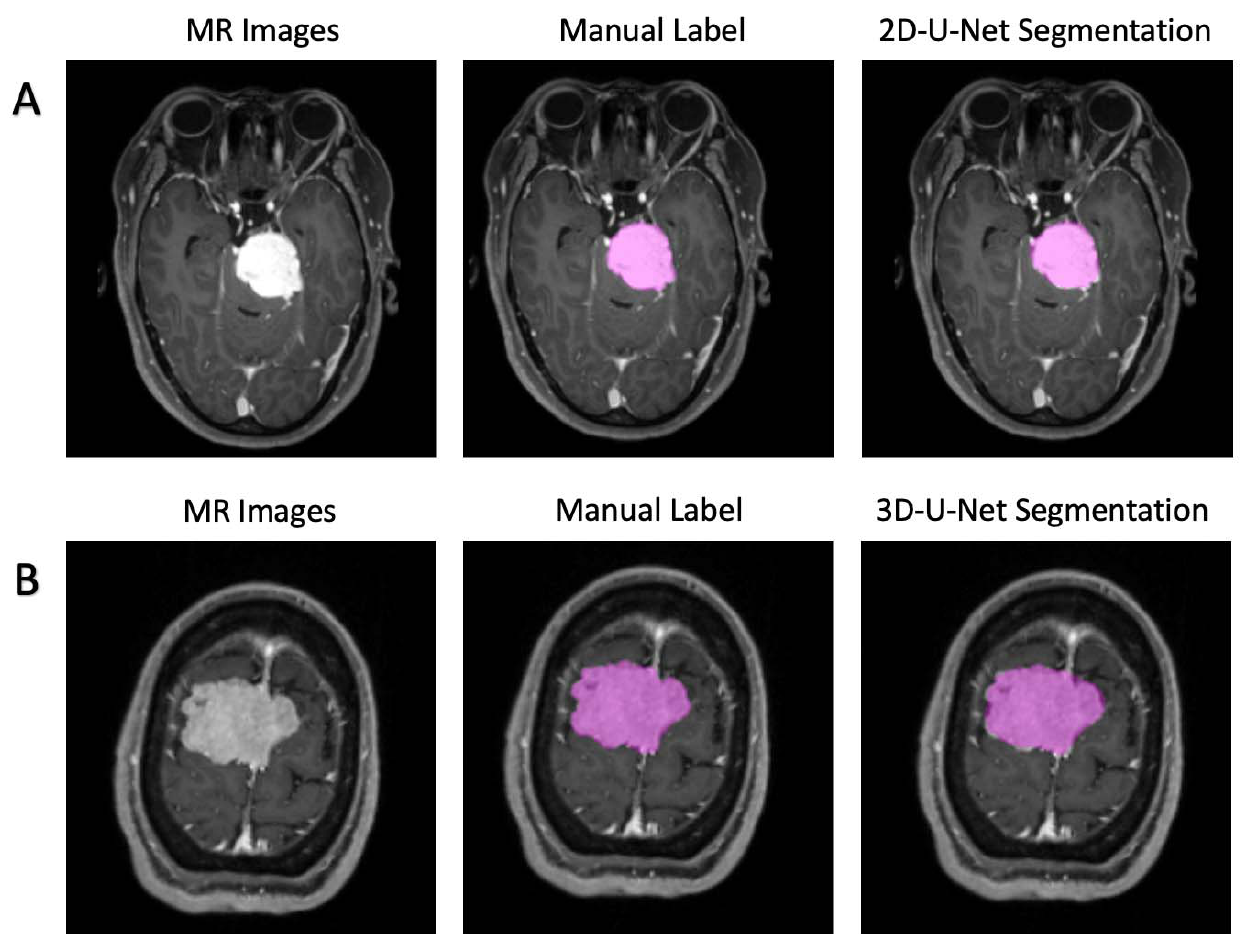
Figure 2. Two examples of the segmentation predicted by U ‐ Net. ( A) . 2D ‐ U ‐ Net architecture; ( B) . 3D ‐ U ‐ Net architecture.